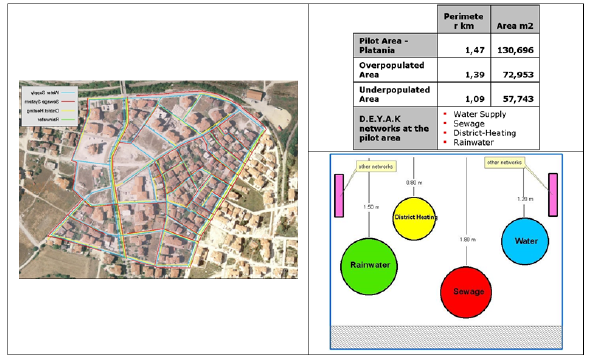
Figure 7: The municipality of Kozani pilot area